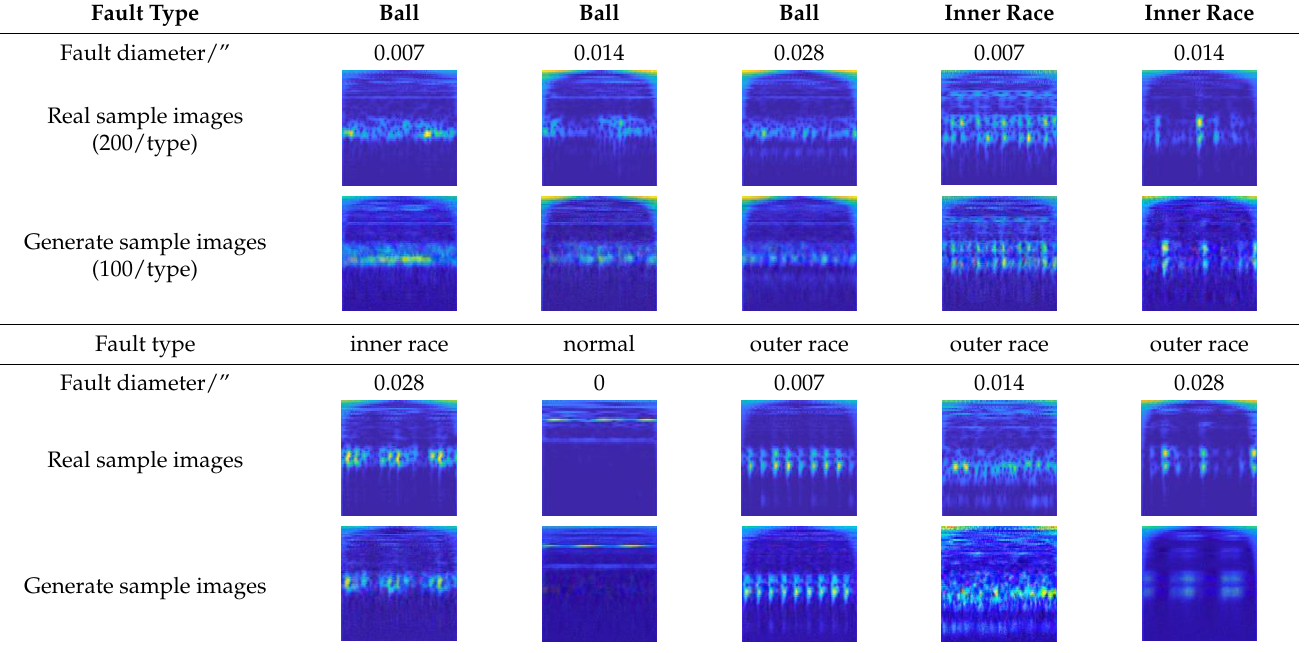
Table 1. Classification of fault types.